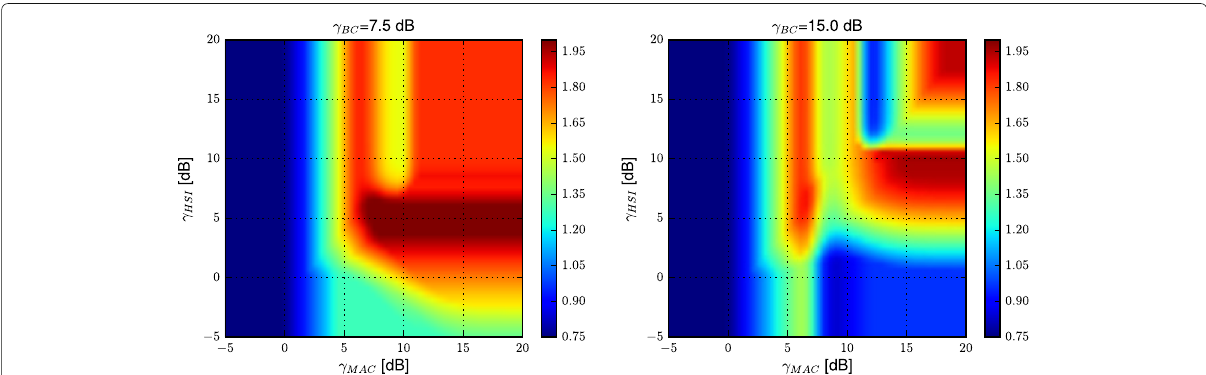
− T LB [bits/channel use] of the coded over uncoded WBN system for C